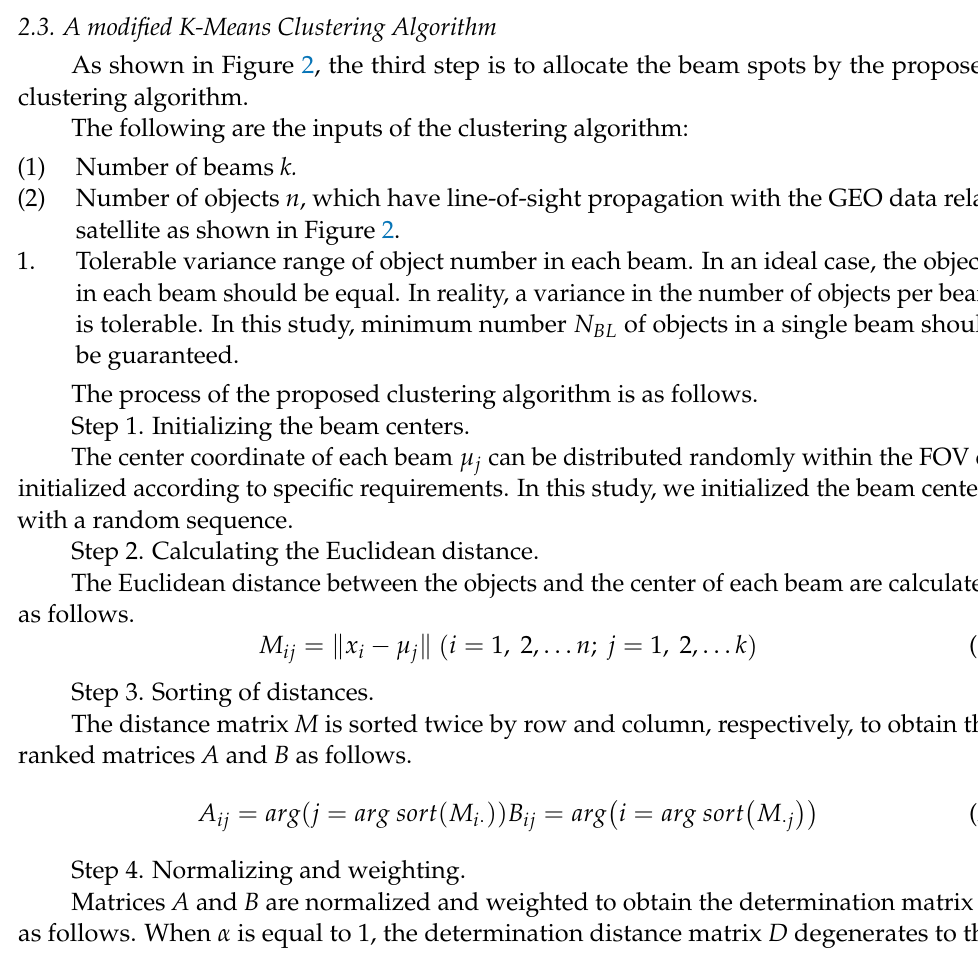
Figure 5. Characteristics of the object distribution in FOV of GEO data relay satellite with 0.5 ◦ spot beams: ( a ) LEO satellite occupation of spot beams. The number in the center of each cell indicates the transient LEO satellites in the coverage of a certain beam. The blue dash line sketches the contour of Earth’s surface; ( b ) statistics of the cell